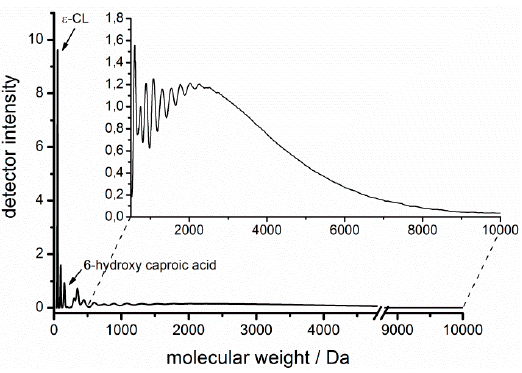
Figure 4. SEC trace for the polymerization of ε -CL in toluene with free CaLB.